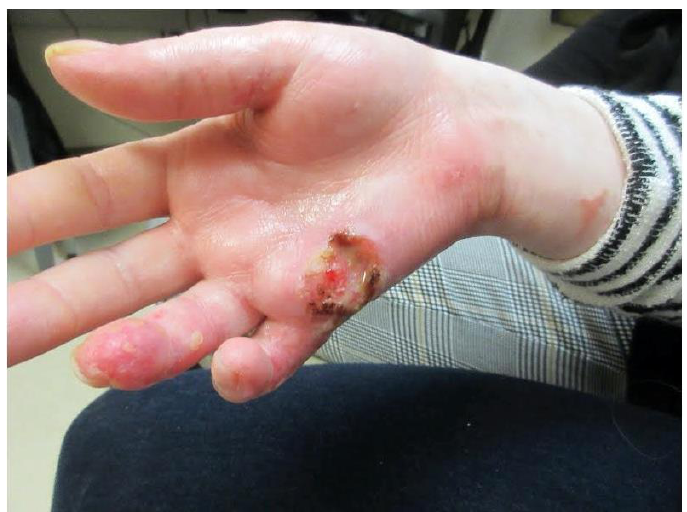
Figure 4. Right ventral hand with 2.4 cm, fissured, indurated, erythematous, ulcerated, and depressed plaque.